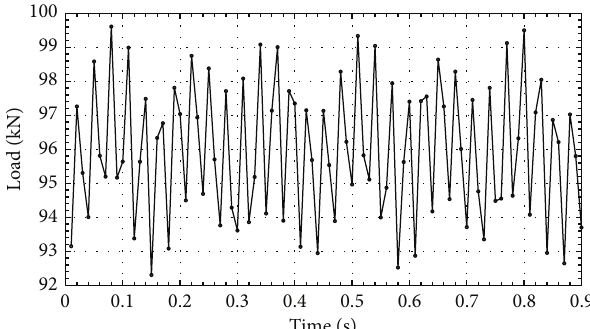
Figure 5: The time-history curve of the train vibration